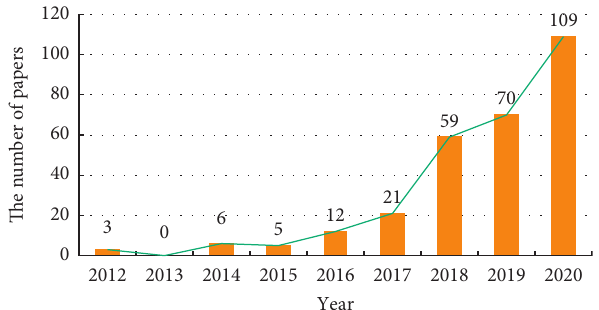
Figure 1: Review process.